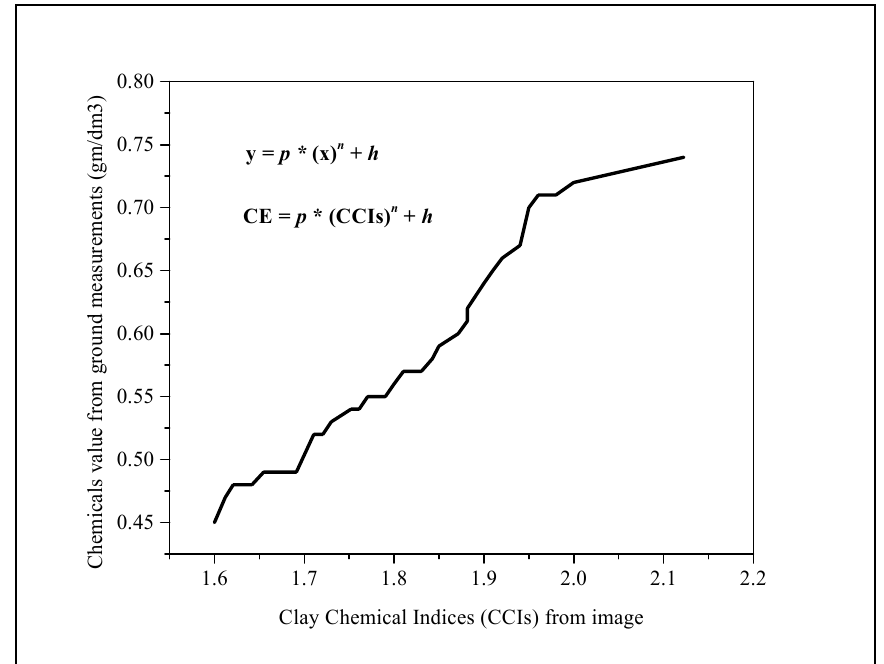
Figure 7. Chemical equation (CE) based on the relationship between the clay chemicals indices from the satellite imagery, and the chemical values of the ground